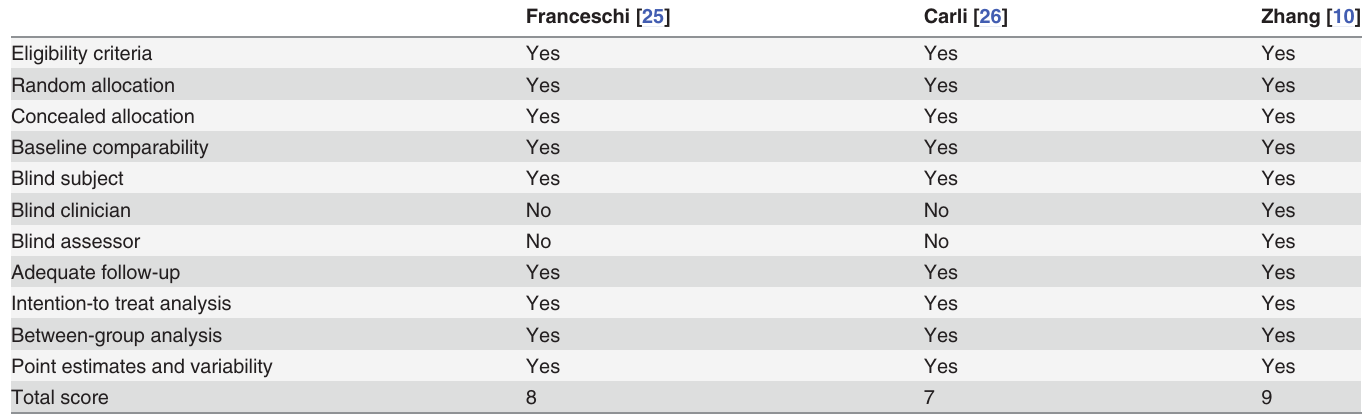
Table 3. RCTs quality ratings (determined using the PEDro critical appraisal